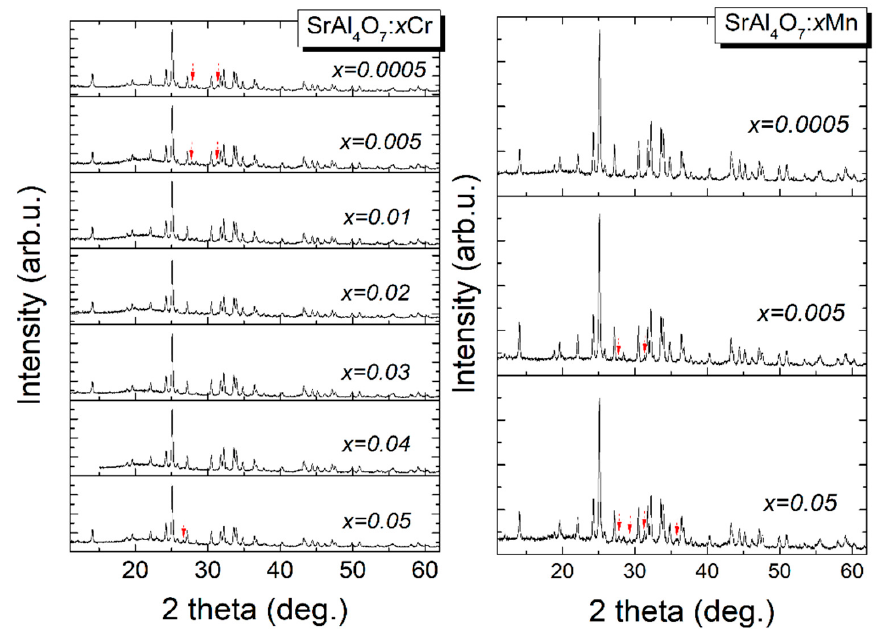
Figure 3. Experimental XRD patterns of SrAl 4 O 7 :xCr 3+ and SrAl 4 O 7 :xMn 4+ powders with different chro ‐ mium and manganese content, annealed at 1100 ° С . Arrows indicate the traces of the foreign phase(s).